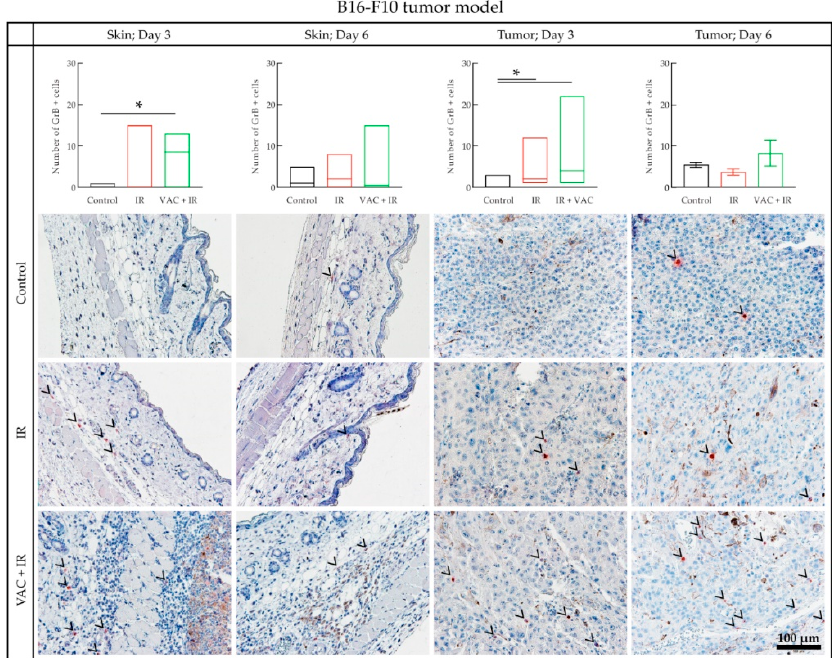
Figure 7. Histological analysis of the B16 ‐ F10 tumor model samples. The number of GrB+ cells in IHC stained skin and tumor samples. Data was plotted as the line at the median with the data range (min, max) (Skin; Day 3, Skin; Day 6, Tumor; Day 3) or as the mean ± standard error (SE) (Tumor; Day 6). Representative images of the samples stained for GrB+ cells for each therapeutic group are under the graphs. The black arrowheads indicate the red GrB+ cells. GrB+ = Granzyme B positive cells; * = p < 0.05 determined by Dunn’s test for multiple comparison; IHC = immunohistochemically; VAC = 1 unit of the B16 ‐ F10 vaccine (0.5 mg), prepared using the adjusted vaccine preparation protocol, including IL ‐ 12 GET; IR = tumor irradiation with 15 Gy; GET = gene electrotransfer.